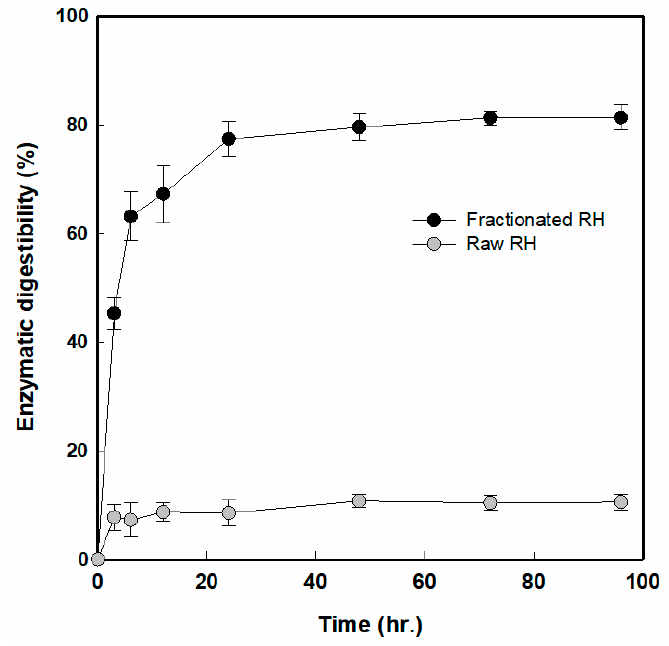
Figure 5. Ninety-six-hour enzymatic digestibility of alkaline-fractionated RH with cellulase loadings of 15 FPU/g glucan. All data are the means of triplicates.